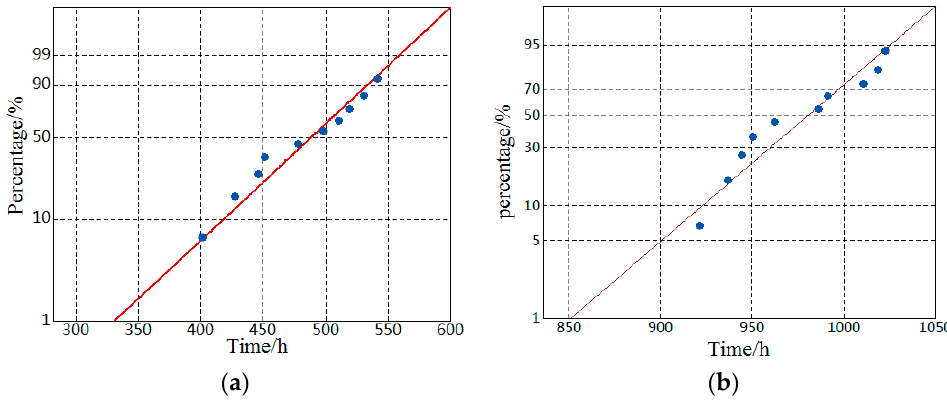
Figure 5. Fitting probability diagram of accelerated life data of MOCRC. ( a ) Group A. ( b ) Group B. The life data of MOCRC obtained from the electrified accelerated test do not rely on any distribution. The fitting line of the transformed distribution is different because of the different distribution, so the probability graph can be used to evaluate the fitting degree between the Gumbel extremum distribution and the electrified accelerated life data. It can be obtained through Figure 5; the electrified accelerated life data of MOCRC are close to the fitting line; the sample points are all near the fitting straight line. It shows that the Gumbel distribution has a good fitting degree for the constant current accelerated corrosion life data of MOCRC. To assess the fitting degree of the Gumbel extremum distribution more accurately, a further test is